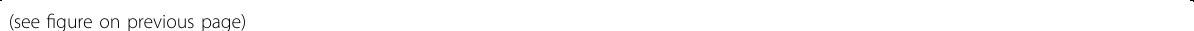
Fig. 1 Metabolic changes induced by aspirin administration and fasting in mice. a – d WT male mice were subjected to 48 h of starvation or treated with aspirin 100 mg/kg i.p. for 6 h, then blood was drawn, and metabolic analyses were performed on plasma ( a ), heart ( b ), liver ( c ) and gastrocnemius muscle ( d ) (for Ctrl n = 10 mice; starvation n = 5 mice; aspirin n = 5 mice). Heat maps (left panels) depict Log2 Fold Change (FC) values to control mice (False Discovery Rate < 0.1) for annotated and putative metabolites (listed in Supplemental Table 1). Bar plots (right panels) display the percentage of metabolic perturbation (i.e. metabolites that are signi fi cantly changed in treated groups ( p < 0.05) compared to Ctrl animals). Aspirin-induced alterations were considered as convergent with starvation when they had the same sign. For statistical analyses, p values were calculated by Fisher ’ s exact test to compare convergence incidences with those in nutrient free, (** p < 0.01; *** p < 0.001). Ctrl control, FC fold change, NF nutrient free. Data associated with fasted animals are shared with